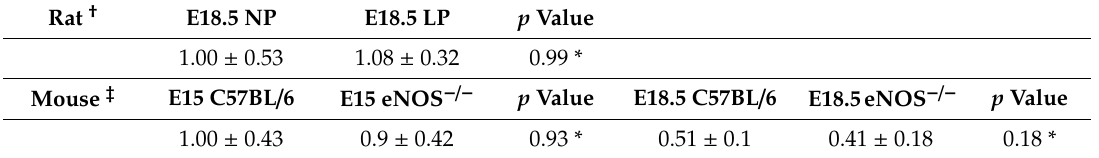
Table 3. Placental CmklR1 mRNA expression (fold-change).